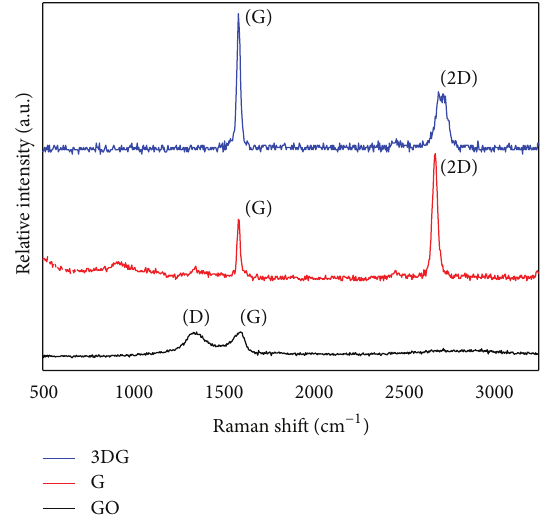
Figure 2: Characterization of graphene, graphene oxide, and three- dimensional graphene-based scaffold by Raman